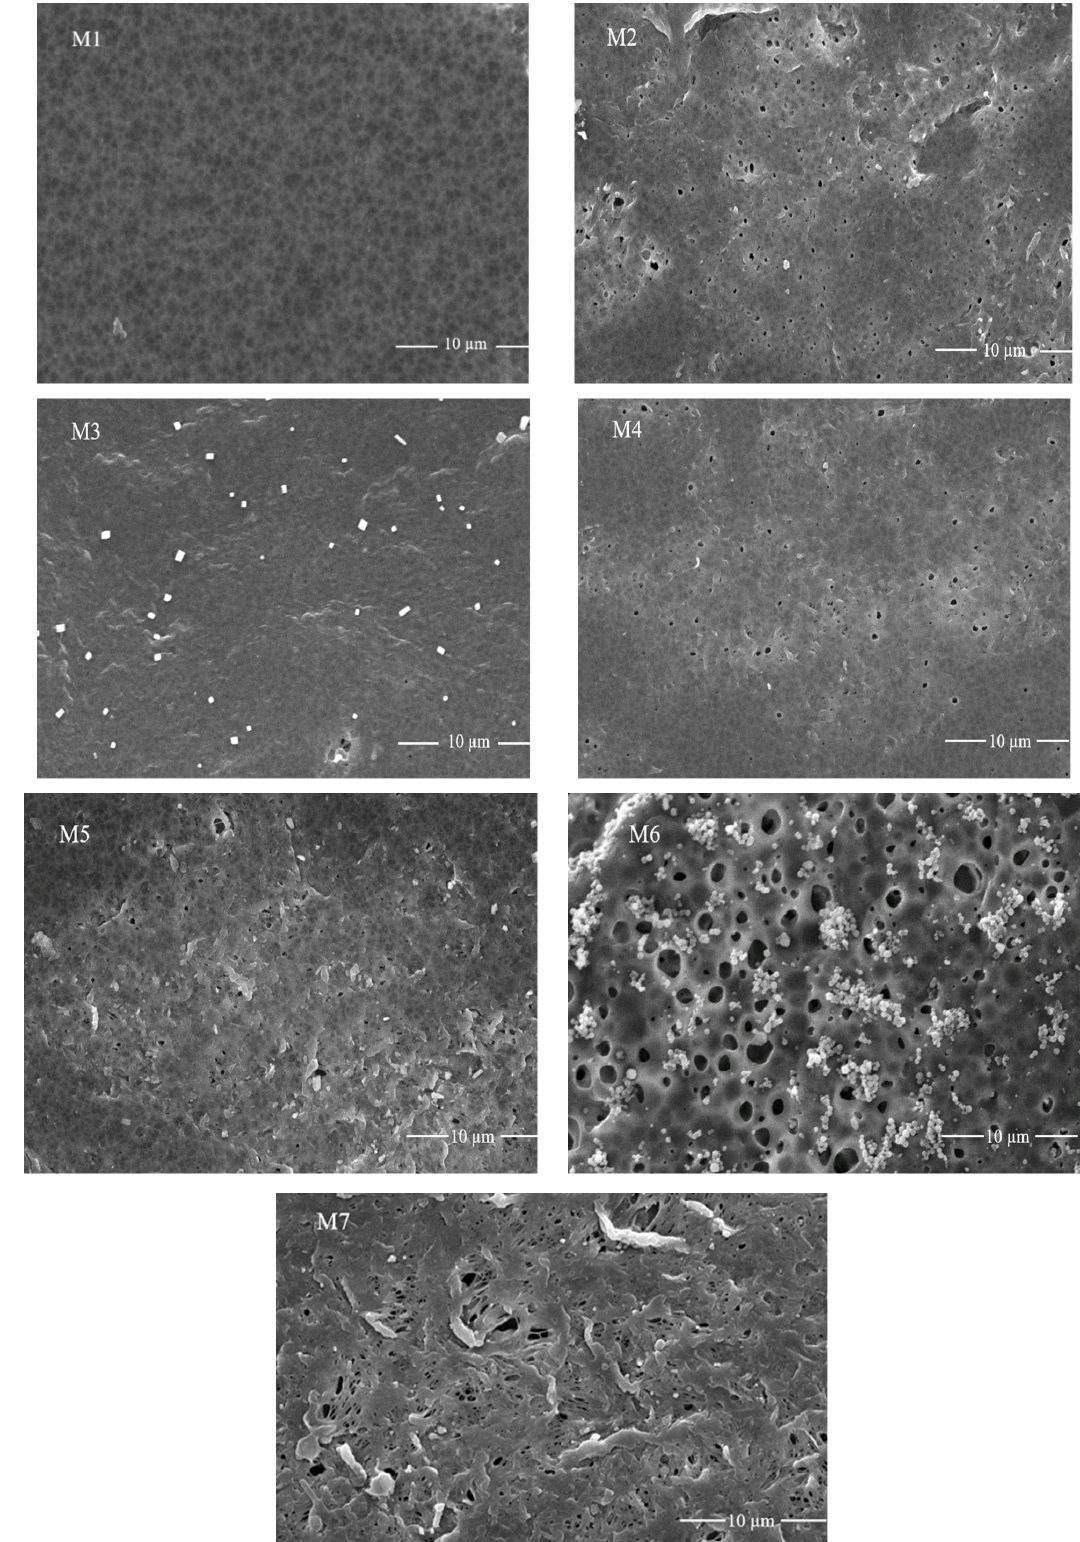
Figure 6. SEM analysis for the surface morphological studies of nanocomposite membranes: Top four membranes from the left named as M1 (PVDF only), M2 (PVDF-1% PVP), M3 (0.1% SGO), M4 (0.2% SGO) and bottom three as: M5 (0.3% SGO), M6 (0.4% SGO) and M7 (0.5% SGO).